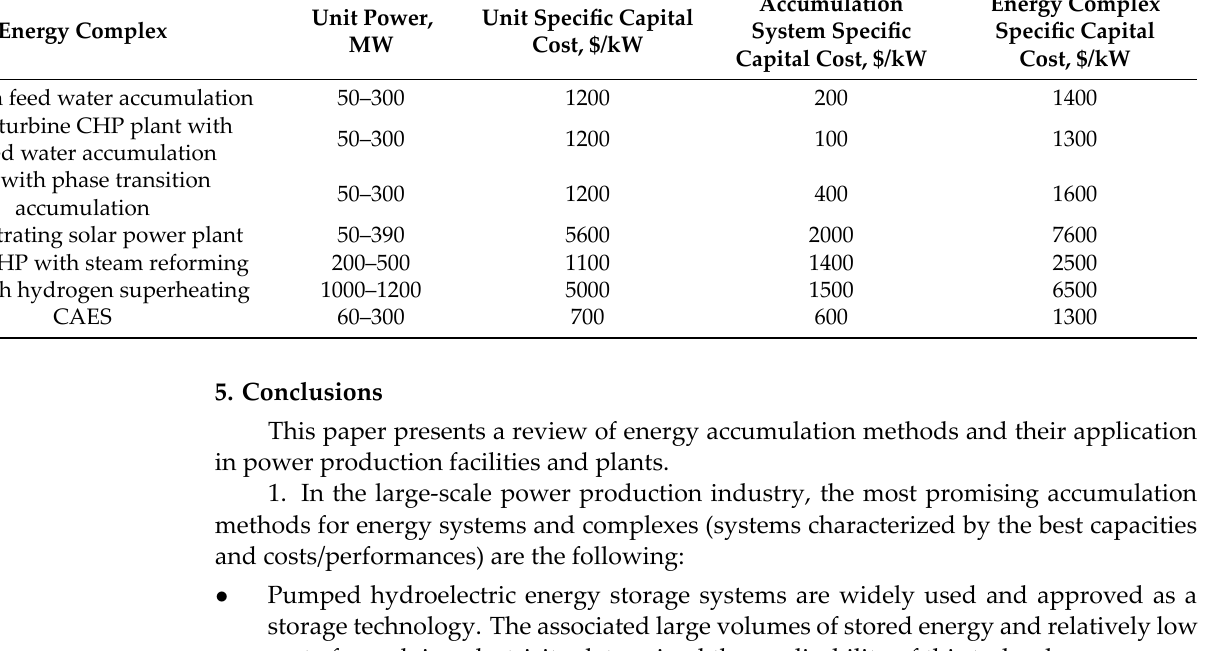
Figure 21. Energy accumulation with air liquation.